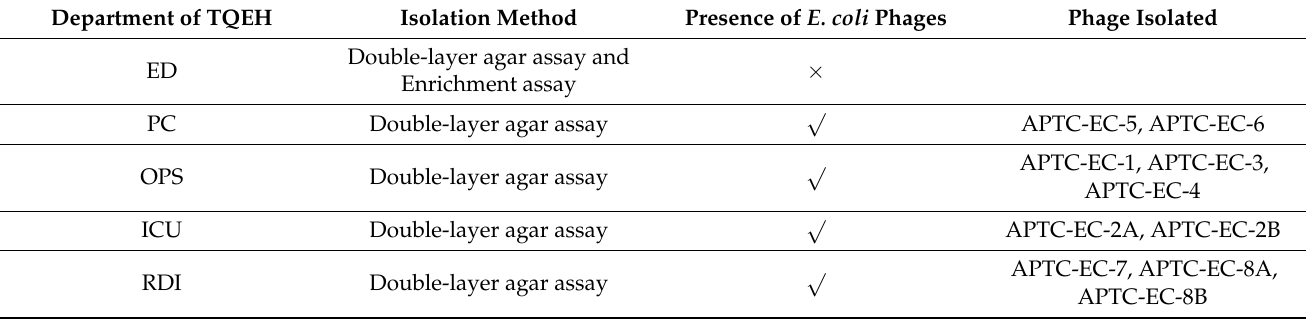
Table 2. Summary of E. coli phages isolation from Wastewater of TQEH. E. coli phage from wastewater from 5 different TQEH departments were screened. E. coli XL Gold was used as